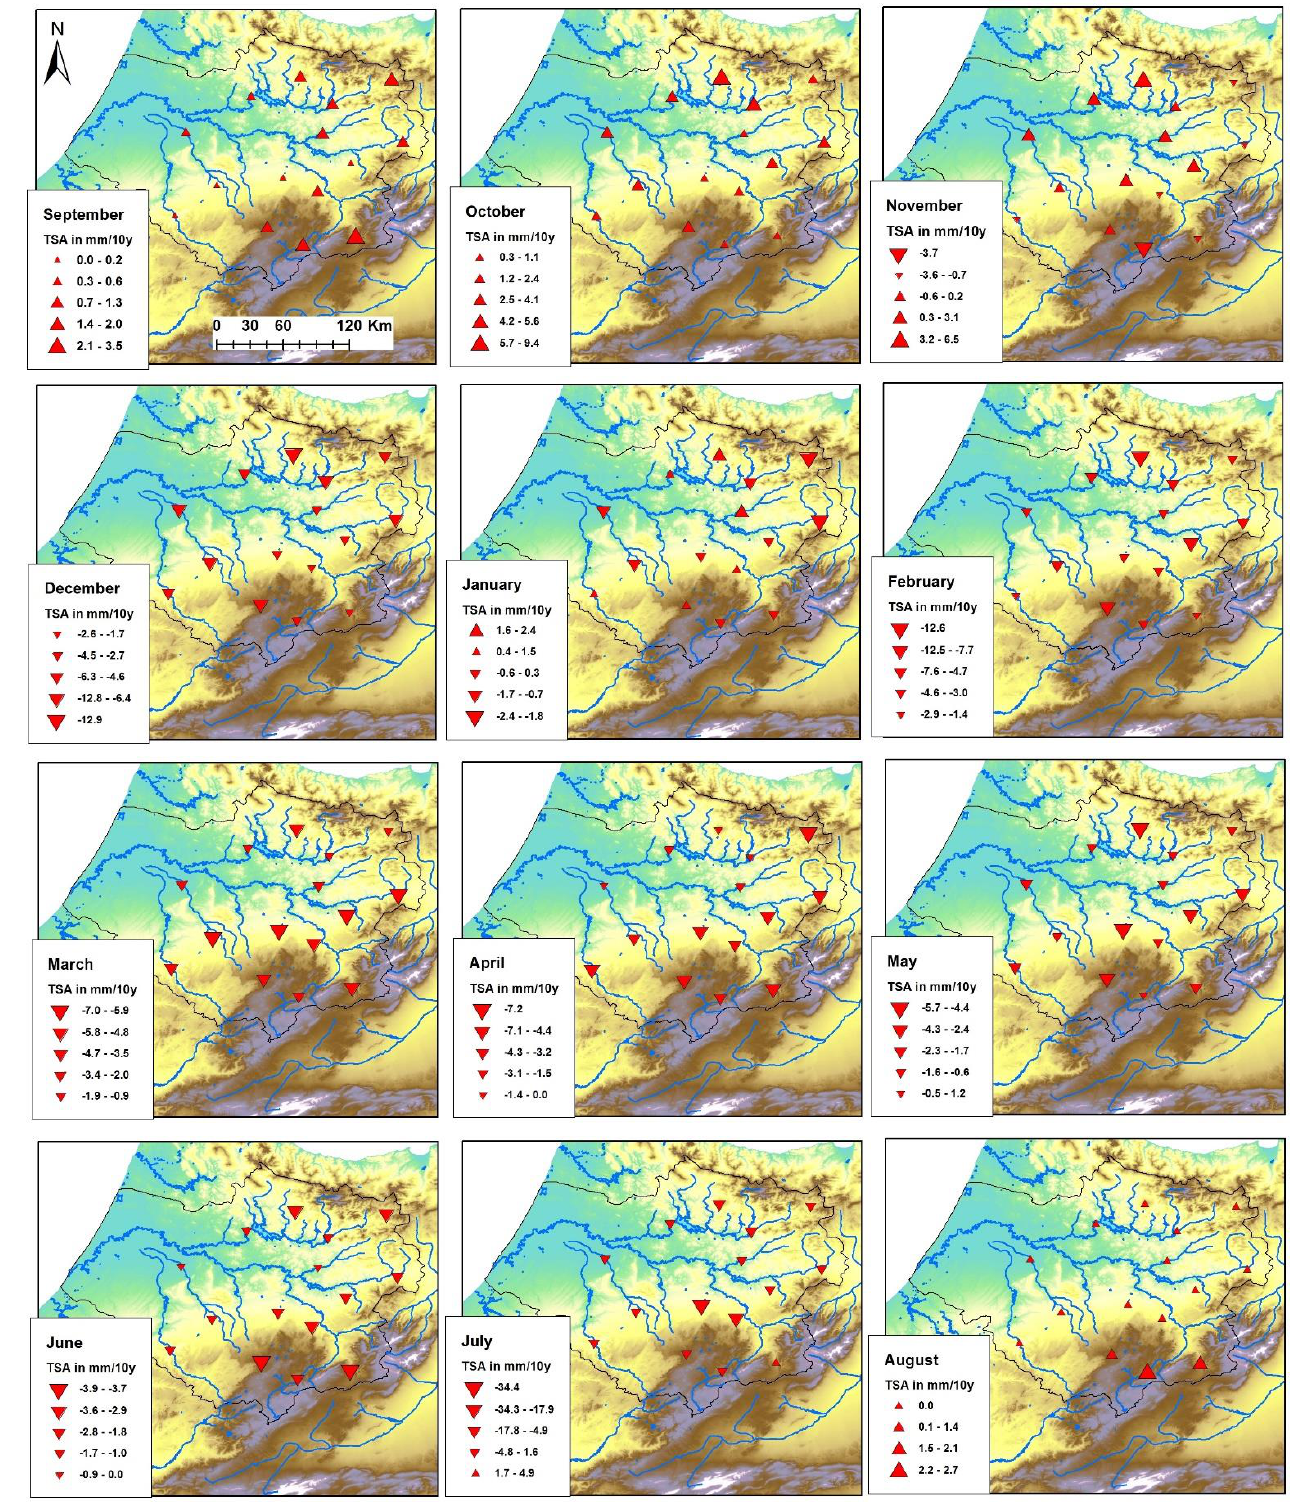
Figure 7. Theil–Sen Slope approach (TSA) for monthly rainfall expressed in mm per decade. Regular Figure 7. Theil – Sen Slope approach (TSA) for monthly rainfall expressed in mm per decade. Regu- lar triangles represent rising rain and inverted triangles represent rain decreases. triangles represent rising rain and inverted triangles represent rain